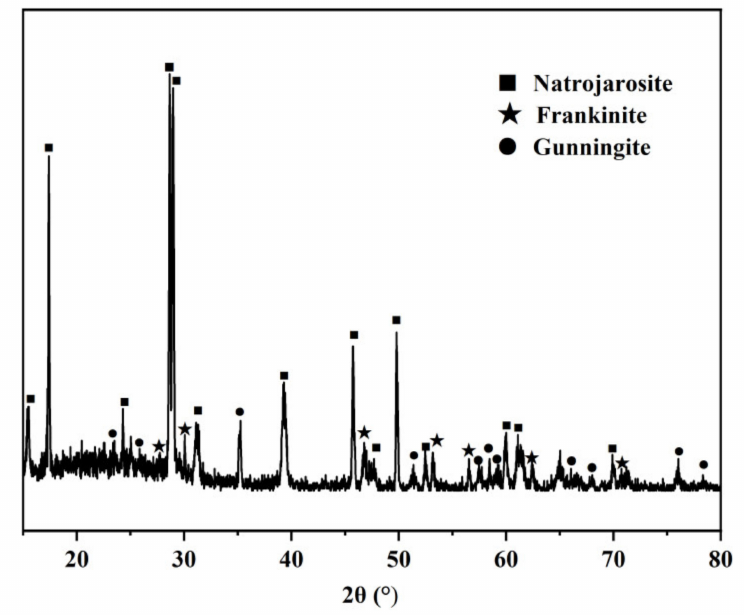
Figure 1. XRD pattern of jarosite residue.